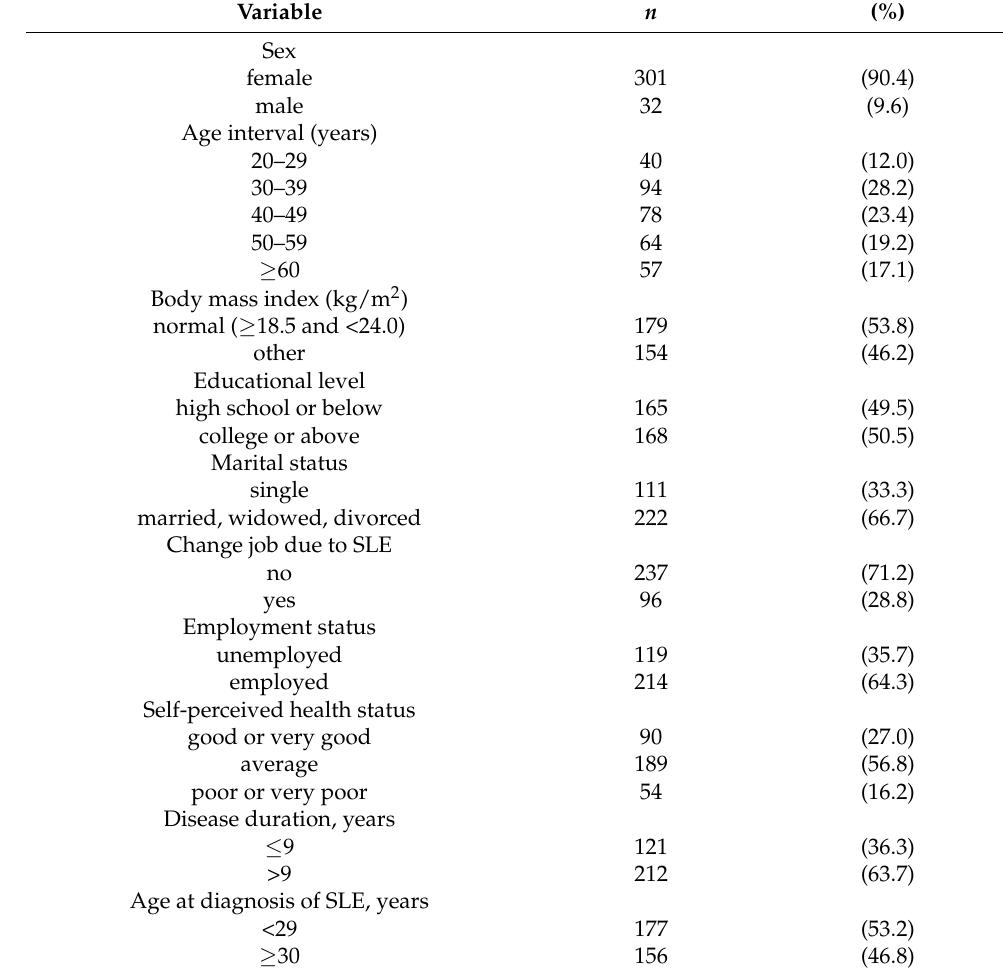
Table 1. Demographic data of patients with systemic lupus erythematosus ( N = 333).